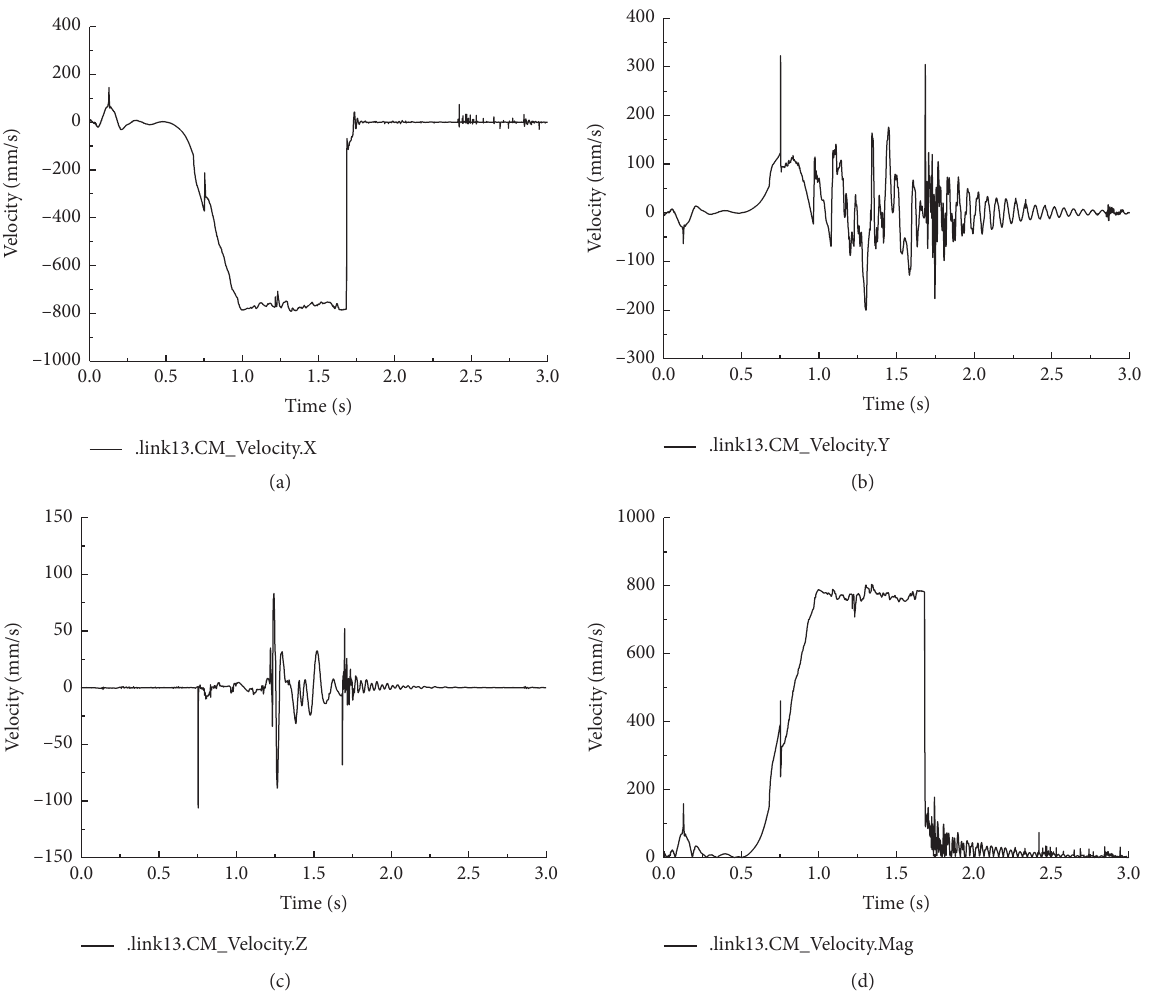
Figure 13: Link acceleration change curve at the chain blocked position. (a) Velocity in the X direction. (b) Velocity in the Y direction. (c) Velocity in the Z direction. (d) Velocity